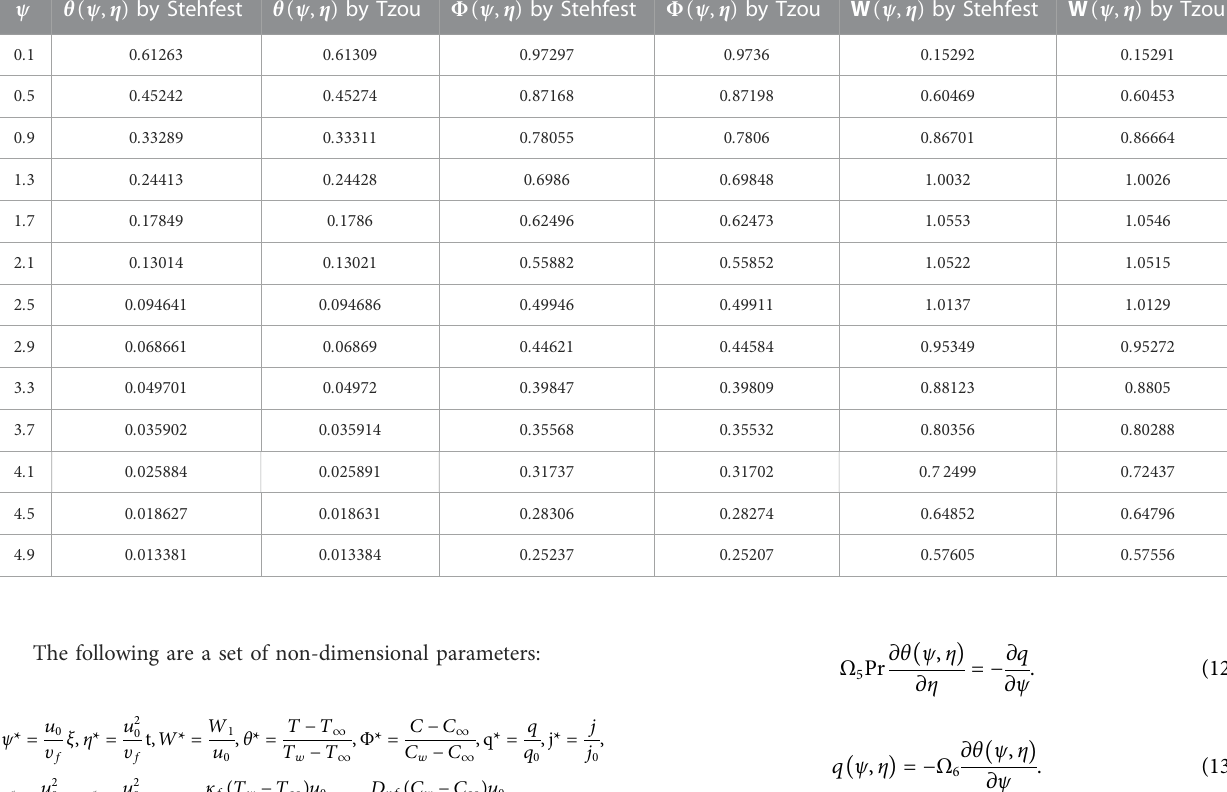
TABLE 2 Numerical comparison of energy, concentration, and velocity pro fi les by different numerical